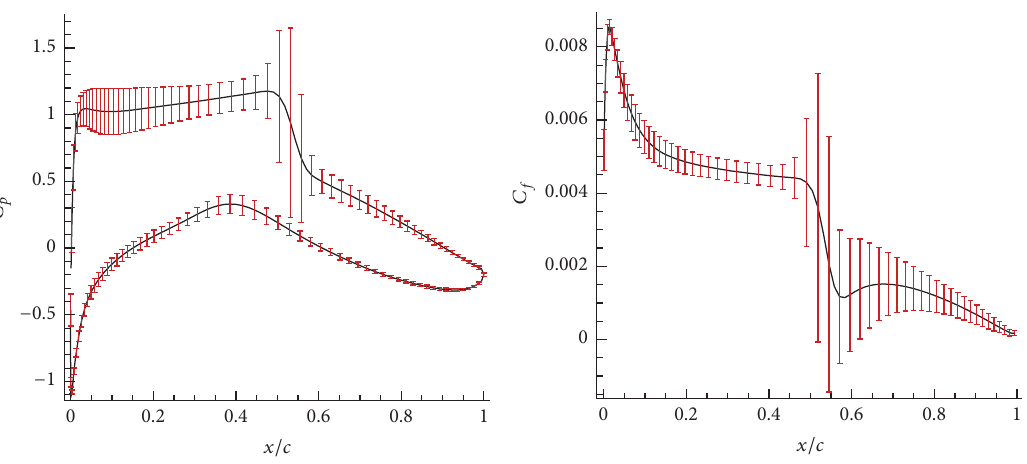
Figure 11: The error bars of 𝐶 𝑝 and 𝐶 𝑓 distribution by UQ.